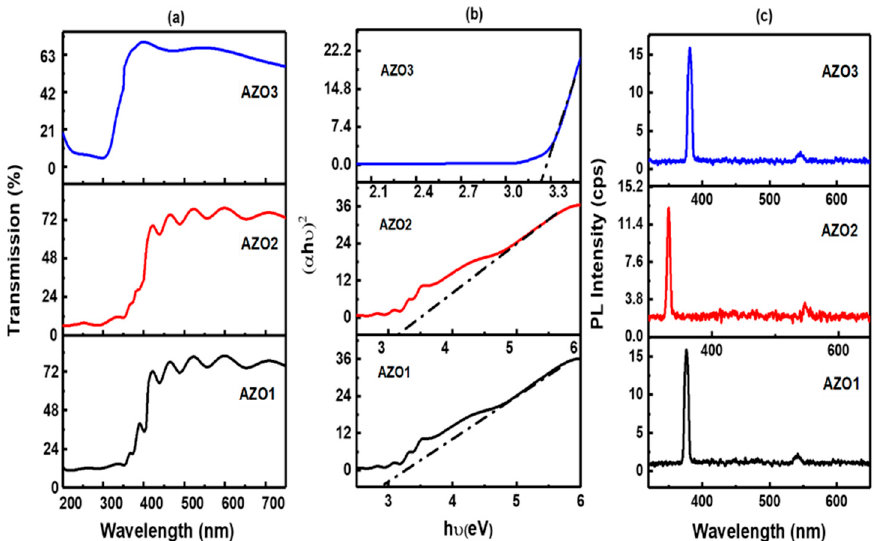
Figure 16. ( a ) Transmission curves for AZO1, AZO2 and AZO3. ( b ) Tauc plots to determine the band gap for AZO1, AZO2 and AZO3. ( c ) PL spectra for a) AZO1, b) AZO2 and c) AZO3. Reproduced with permission from Ref. [61]; published by Springer Nature, 2019.